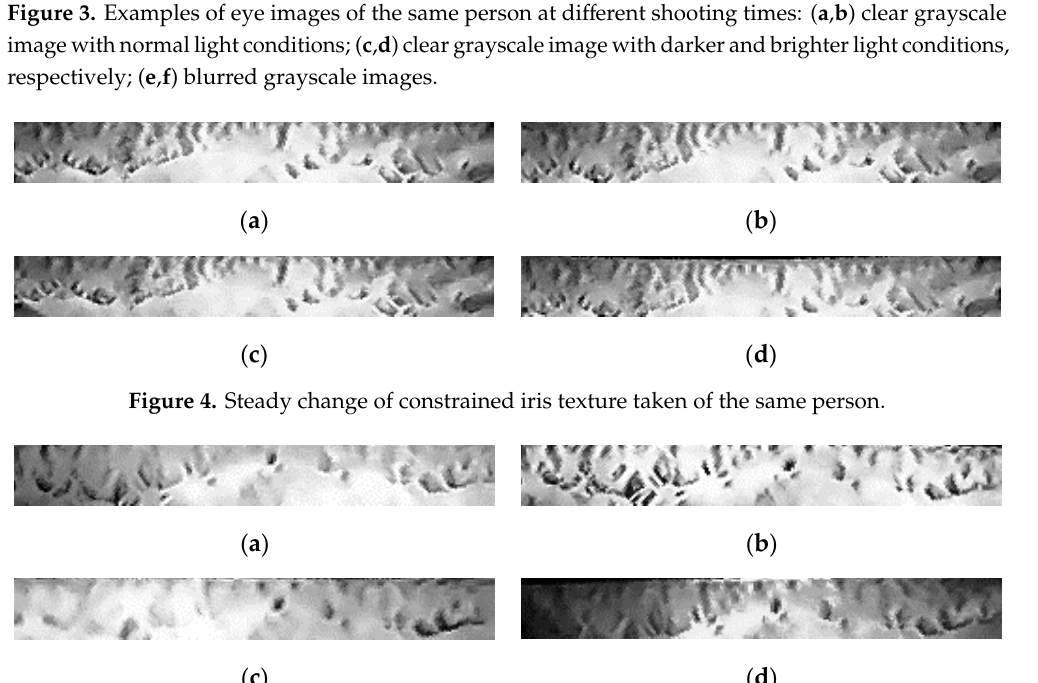
Figure 5. Unsteady change of constrained iris texture taken by the same person: ( a ) normal; ( b ) normal illumination clear and undeflected; ( c ) normal illumination blur and deflected; ( d ) dark illumination clear and undeflected.